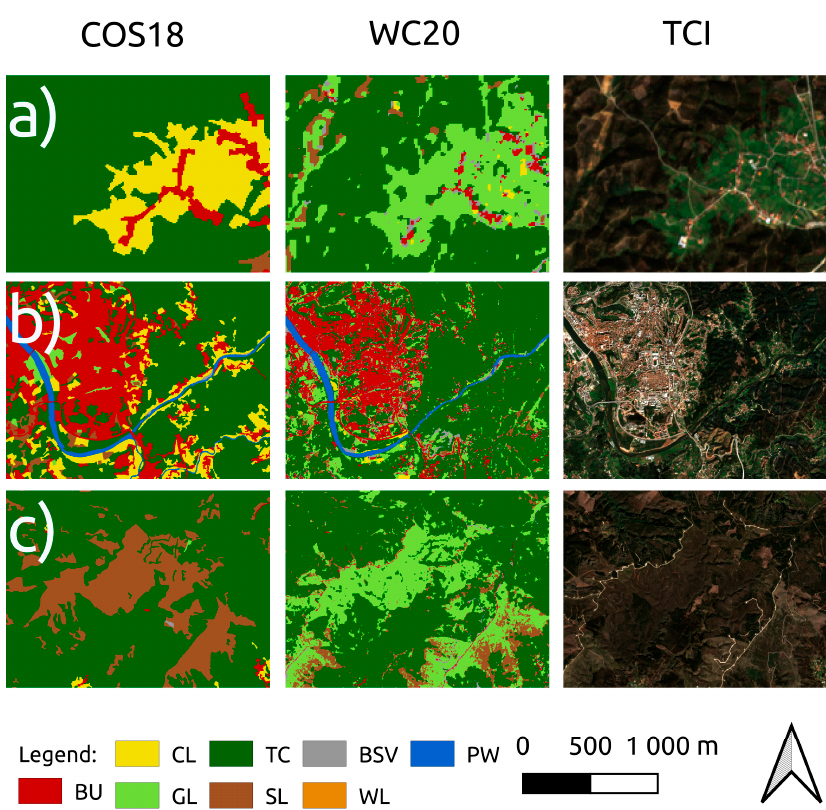
Figure 3. Details depicting three different areas (rows ( a–c )) regarding COS18 (mapped to the WC20 nomenclature, see Section 4.1), WC20 and TCI (true color image, Sentinel-2).